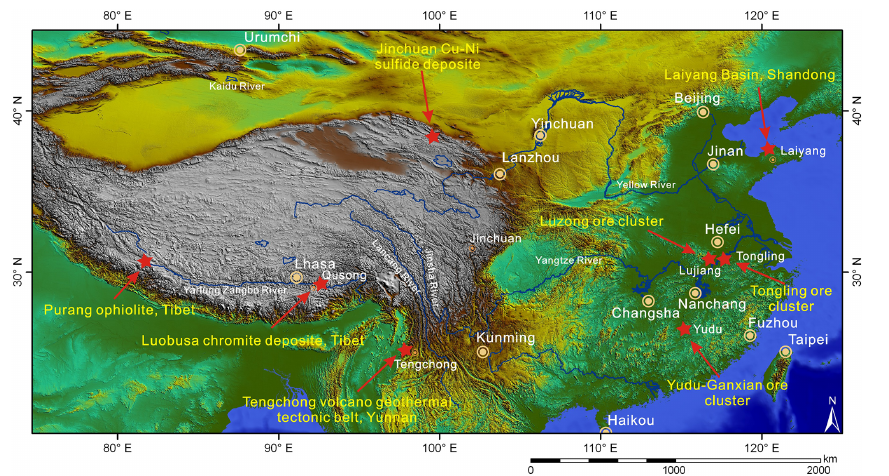
Figure 15. Location of boreholes of Program of Selected Continental Scientific Drilling and